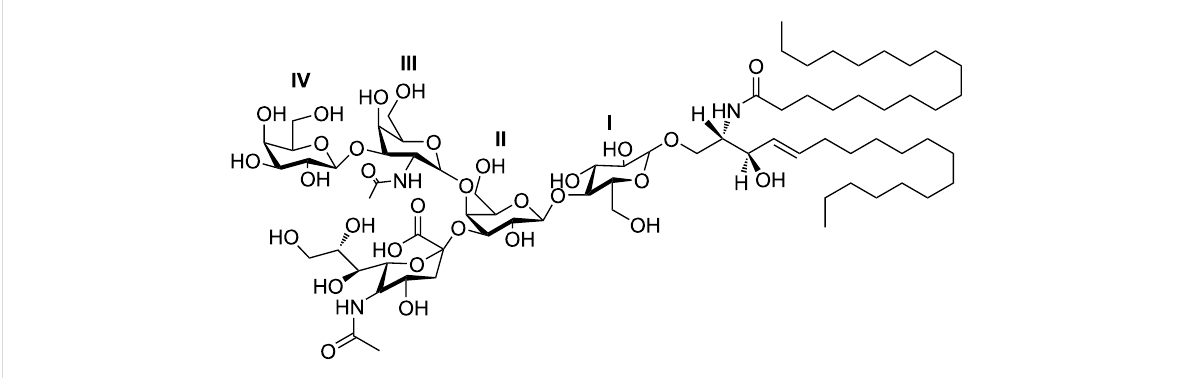
Figure 1: Chemical structure of ganglioside GM1a (a β - ᴅ -galactosyl-(1 → 3)- N -acetyl- β - ᴅ -galactosaminyl-(1 → 4)-[ α - N -acetylneuraminyl-(2 → 3)]- β - ᴅ - galactosyl-(1 → 4)- β - ᴅ -glucosyl-(1 ↔ 1)-ceramide). Substituents of the core are labelled with Roman numerals I – IV ( I , Glc; II , Gal; III , GalNAc; IV , Gal). IUPAC name: II 3 Neu5Ac-Gg 4 Cer.